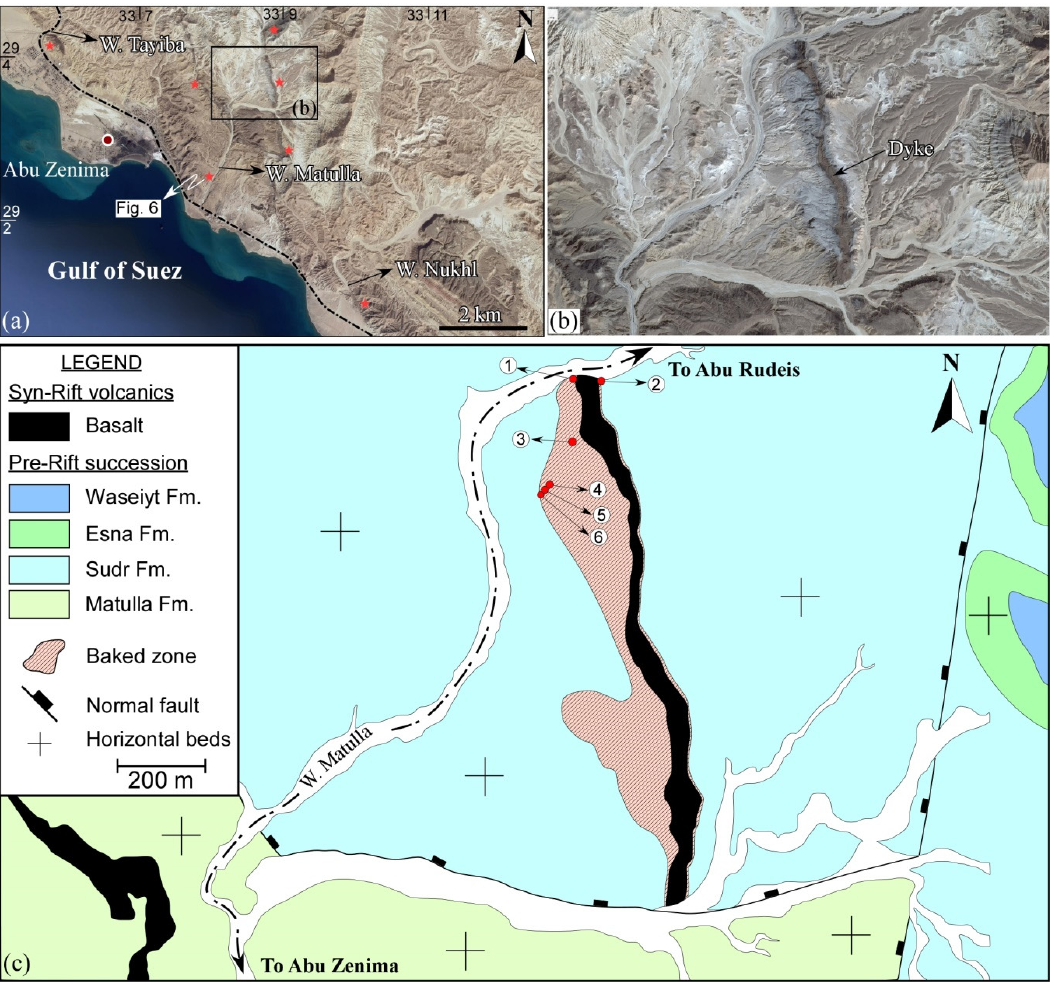
Figure 2. ( a ) A Google Earth map showing the location of the study area (inset labeled Figure 2 in Figure 1), and the distribution of some Tertiary basalt in and outside the study area (marked by red stars). ( b ) A close-up view of the study area (inset (b) in (a)). ( c ) A geologic map of (b) showing the extension of the NNW-trending dyke, the major faults, and the different rock units cropping out in the study area. Red circles refer to the number and location of the collected samples. Fm., Formation.